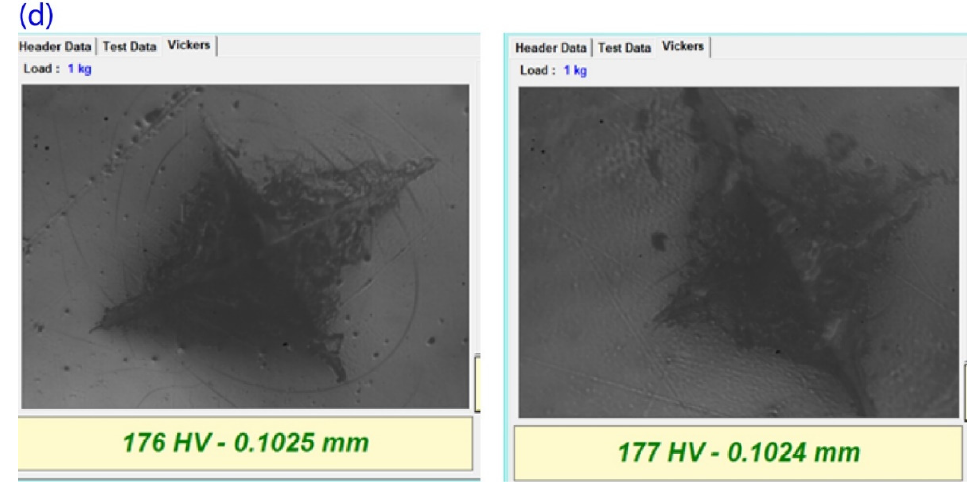
Figure 8. Micro-Vickers hardness of ( a ) graphene composites, ( b ) hBN composites, and micro-Vicker hardness images of ( c ) graphene composites, ( d ) hBN composites. Table 7. Micro hardness values of hBN and graphene-filled composites.